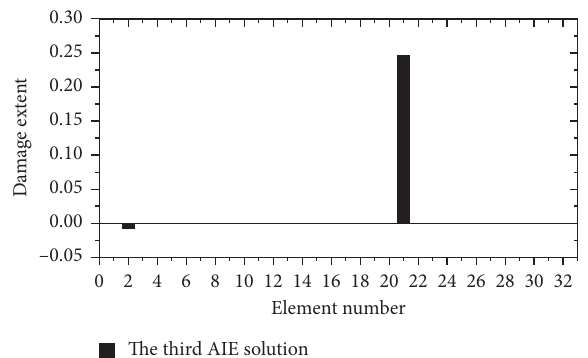
Figure 14: Damage assessment result by the third AIE when element 21 is damaged.